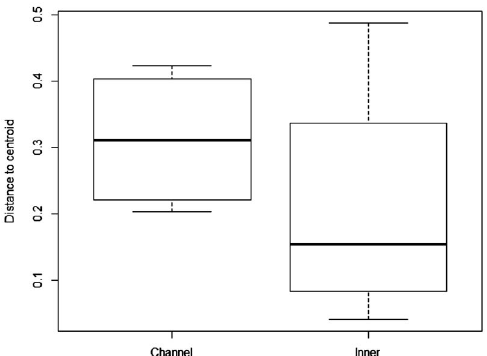
Fig. 4. Distance from the group centroid of the Channel and Inner Clusters of sites, using the Jaccard index as a dissimilarity measure- ment. The horizontal line within each box shows the median, the bottom and the tops of the box shows the 25th and 75th percentiles, respectively. The vertical dashed lines show either the maximum and minimum value or 1.5 times the interquartile range.